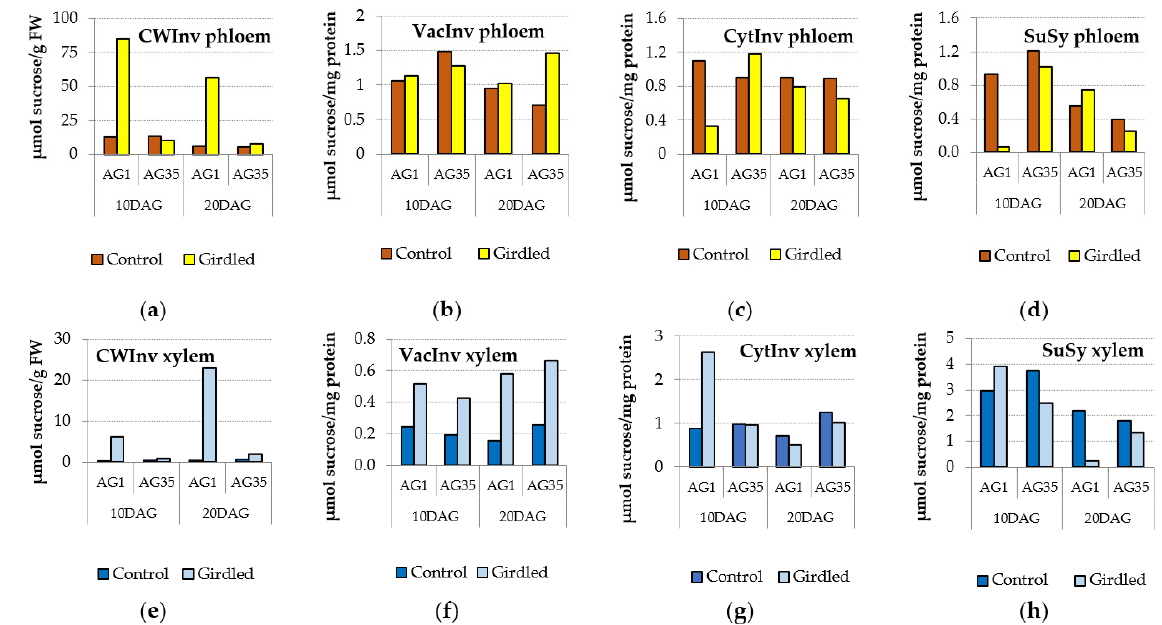
Figure 6. Activity of sucrose-metabolizing enzymes in the phloem ( a – d ) and xylem ( e – h ) in control and girdled trees. CWInv: cell wall invertase; VacInv: vacuolar invertase; CytInv: cytosolic invertase; SuSy: sucrose synthase.